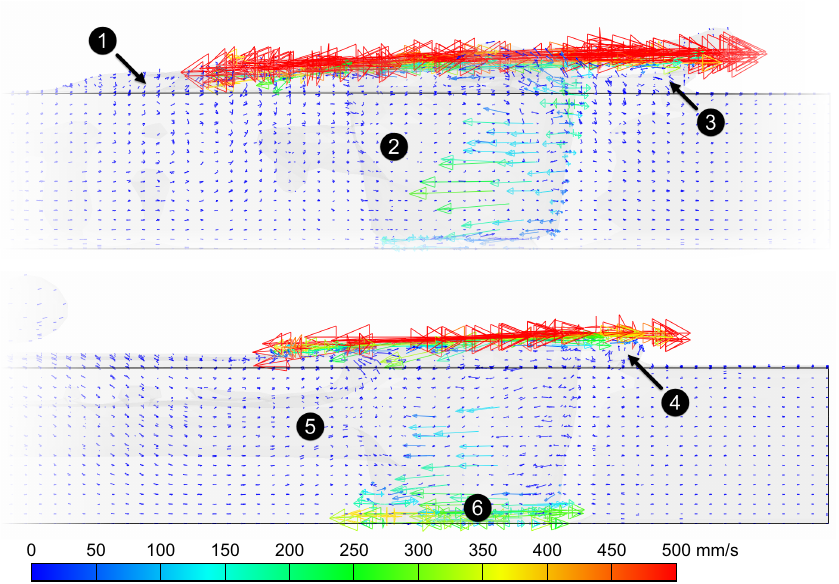
Figure 9. Semi-transparent section along the welding direction showing the local velocity distribution. At the top, shortly after the start of the traverse movement, at the bottom after reaching the process’ steady state. Voids shaded, tool not shown.